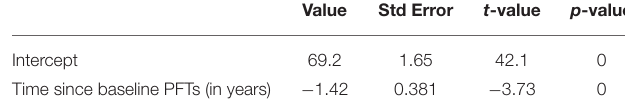
TABLE 2 | Longitudinal Decline in FVC over time. Value Std Error t -value p -value Intercept 69.2 1.65 42.1